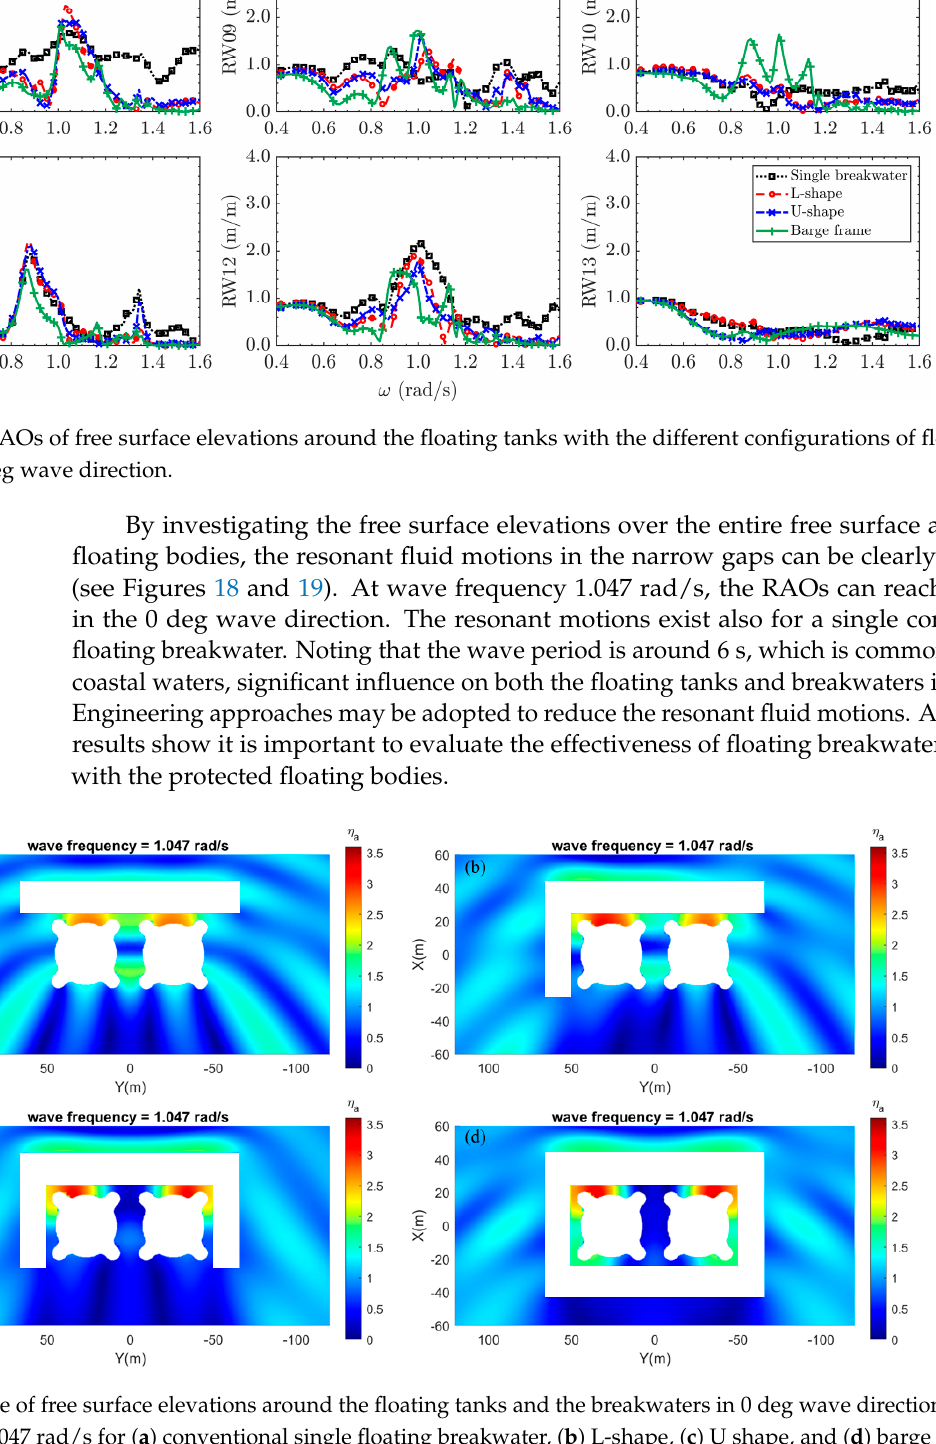
Figure 16. Motion RAOs of free surface elevations around the floating tanks with the different configurations of floating breakwaters in 0 deg wave direction.